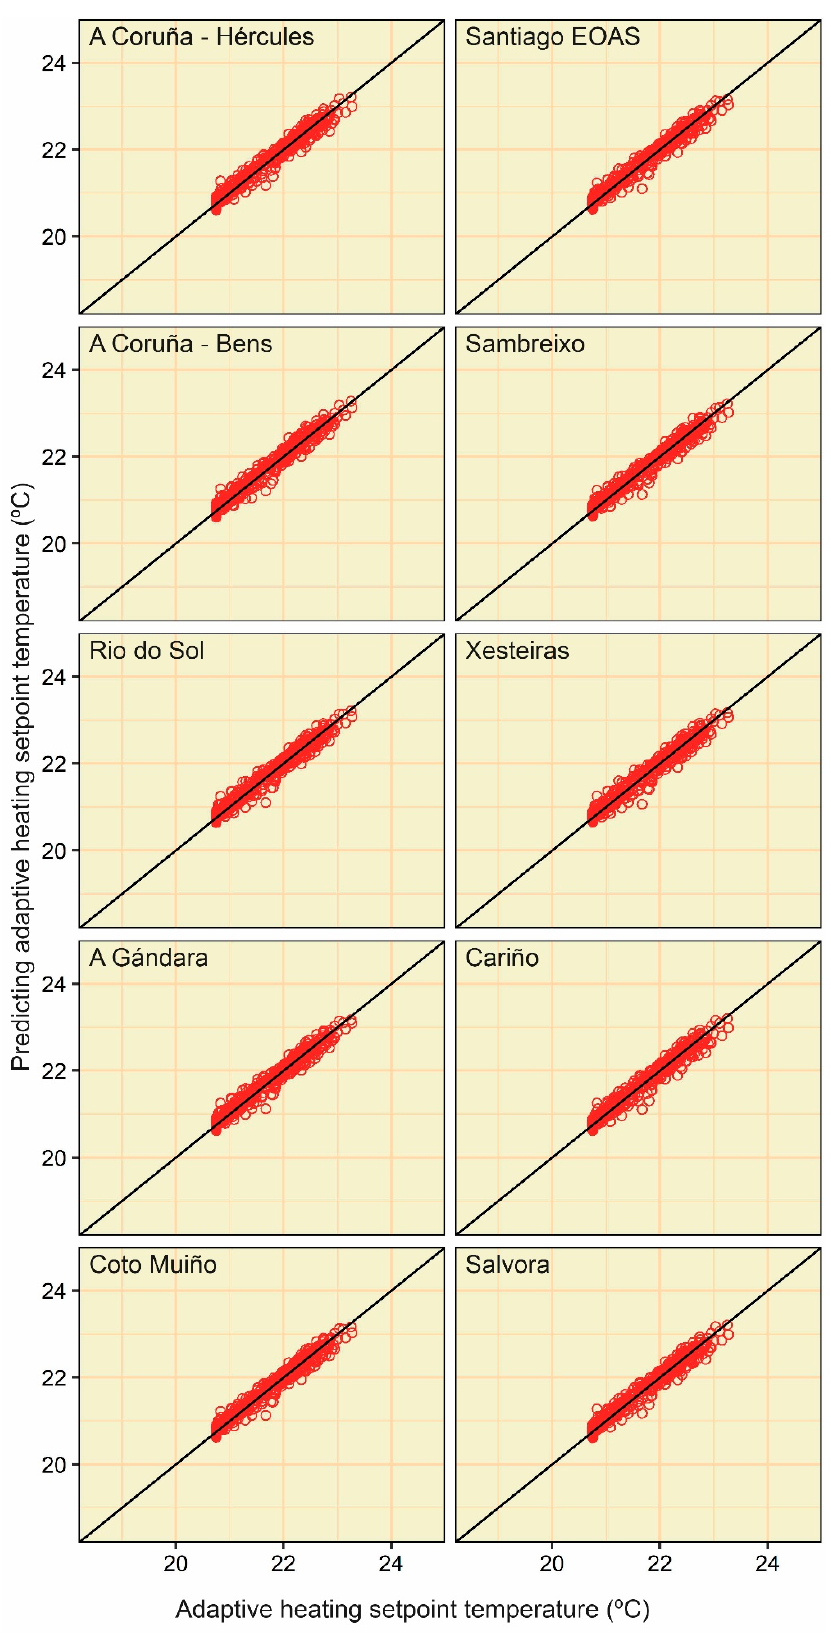
Figure A14. Point clouds between the actual and predicting adaptive heating setpoint temperature values (category II) of the MLR (approach 1).